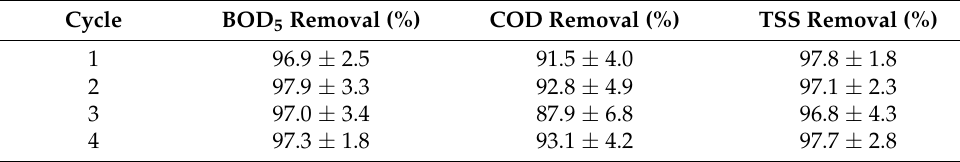
Table 4. Removal efficiencies in the different operating